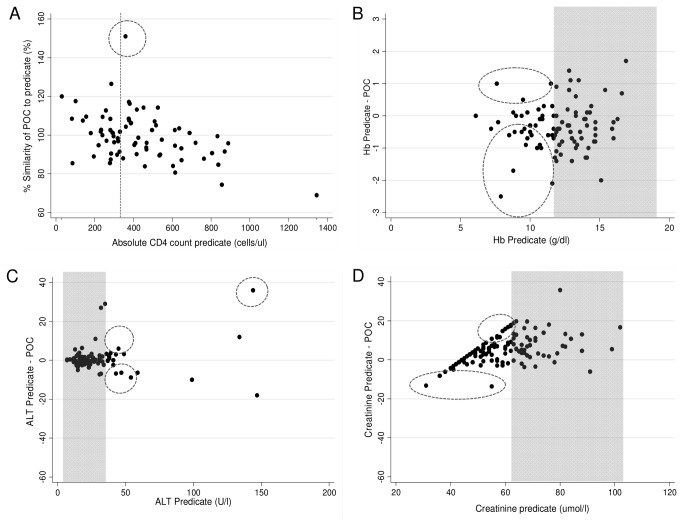
Scatter plots of method comparison of POC testing from a single fingerstick compared to routine laboratory methodology (phase II).A) Percentage similarity for CD4. Red dashed line indicates misclassification point of 350 cells/ul and circle highlights outliers. B-D) Bland Altman difference scatter plots for POC versus predicate methodology for Hb (B), ALT (C) and Cr (D). Grey areas indicate normal ranges for analytes based on predicate method and circles highlight outliers mostly based on RCPA guidelines.